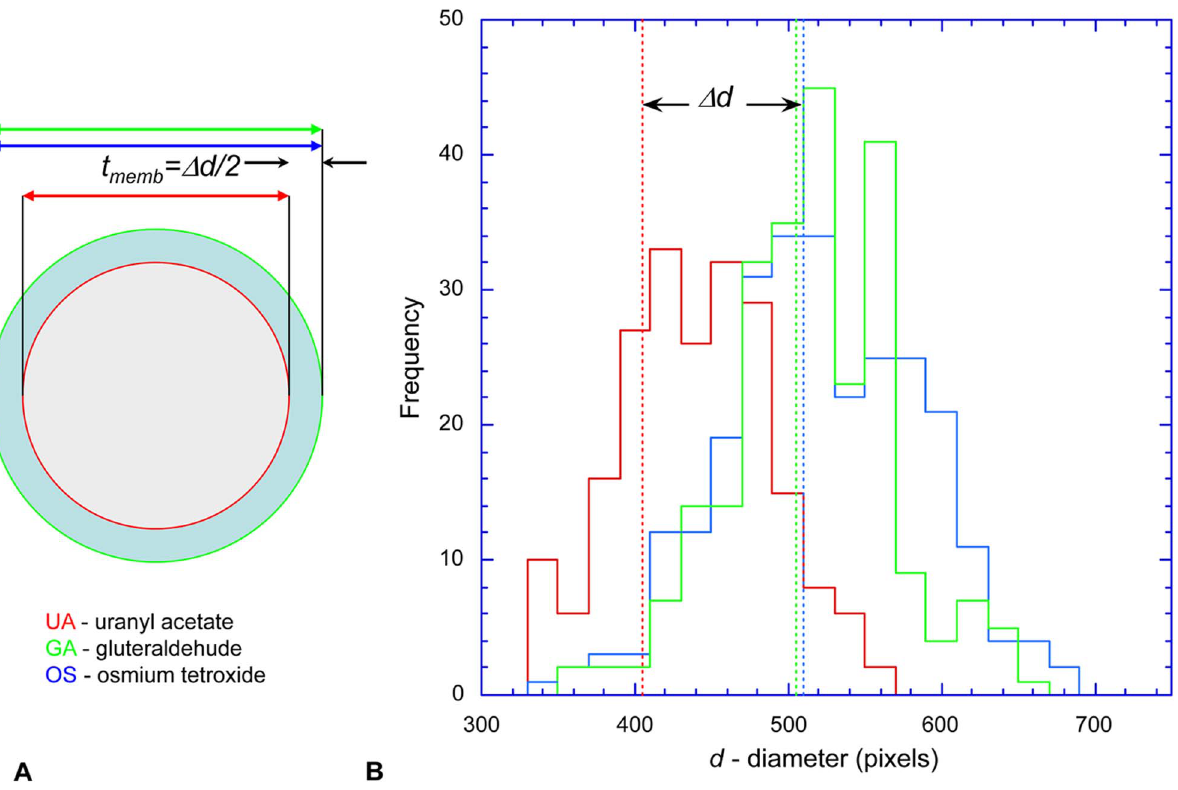
Figure 7. Estimating the cell membrane thickness. [A] The membrane of cells freeze-substituted in acetone/uranyl acetate (UA, red) is not contrasted, whereas the cytoskeleton is highly contrasted, so that its interface (red line) with the cytoplasm (gray) is sharply resolved. In cells freeze- substituted in acetone/osmium tetroxide (OS, blue) or acetone/glutaraldehyde (GA, green), the membranes themselves (light blue ring) are highly contrasted. The difference ( D d /2) in projected diameters of circular cross-sections (arrows) of differentially stained cells is a good estimate of membrane thickness, t memb . [B] Histograms of diameters of circular cross-sections of cells freeze-substituted in uranyl acetate (UA, red), osmium tetroxide (OS, blue) and glutaraldehyde (GA, green) are shown. The average diameters of the GA and OS specimens are very similar – 504 6 53 and 511 6 63 pixels (SD), respectively – whereas that of UA – 403 6 40 – is smaller. The difference ( D d ) indicated by the double-headed arrow implies that the membrane thickness, t memb , is , 0.2 d /2. The pixel size is 0.39 nm. See Fig. 1B. our determination of total cell mass, M cell ~ 3 : 69 | 10 { 14 g , and For an average Spiroplasma cell volume V cell ~ 1 : 65 | 10 8 nm 3 the mass fraction of RNA in freeze-dried cell pellets, f RNA ~ 0 : 086 ; ( Table 2 ), we obtain an RNA content of 3 : 25 | 10 { 15 g per cell, which corresponds to 1 : 96 | 10 9 Da or 5 : 94 | 10 6 bases per cell.